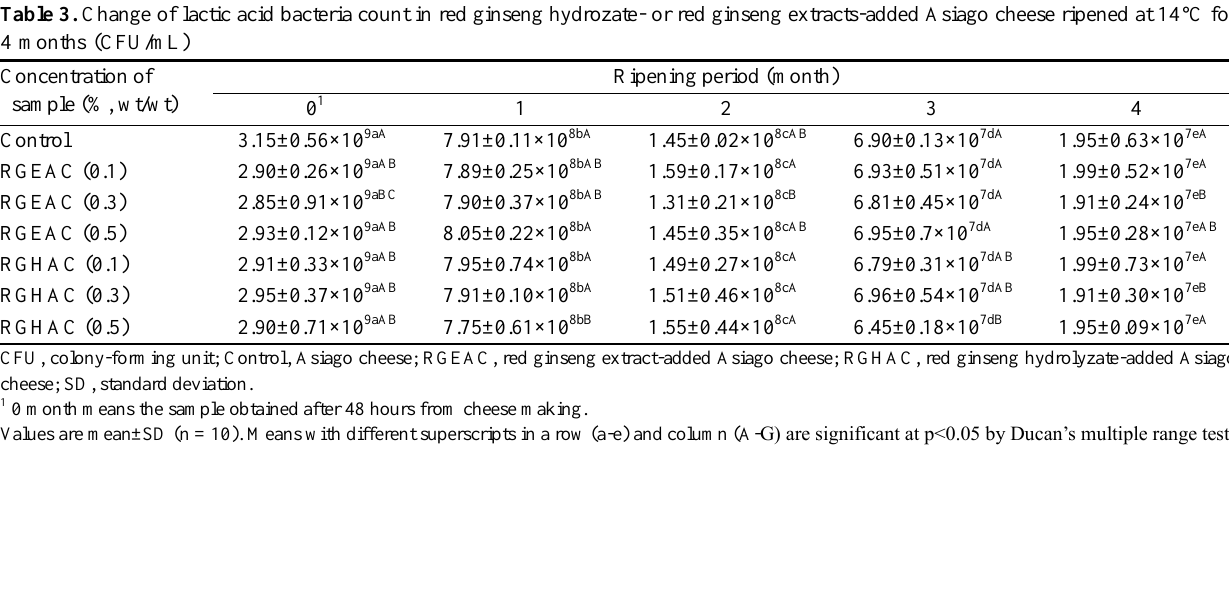
Table 3. Change of lactic acid bacteria count in red ginseng hydrozate- or red ginseng extracts-added Asiago cheese ripened at 14°C for 4 months (CFU/mL) Concentration of sample (%, wt/wt)